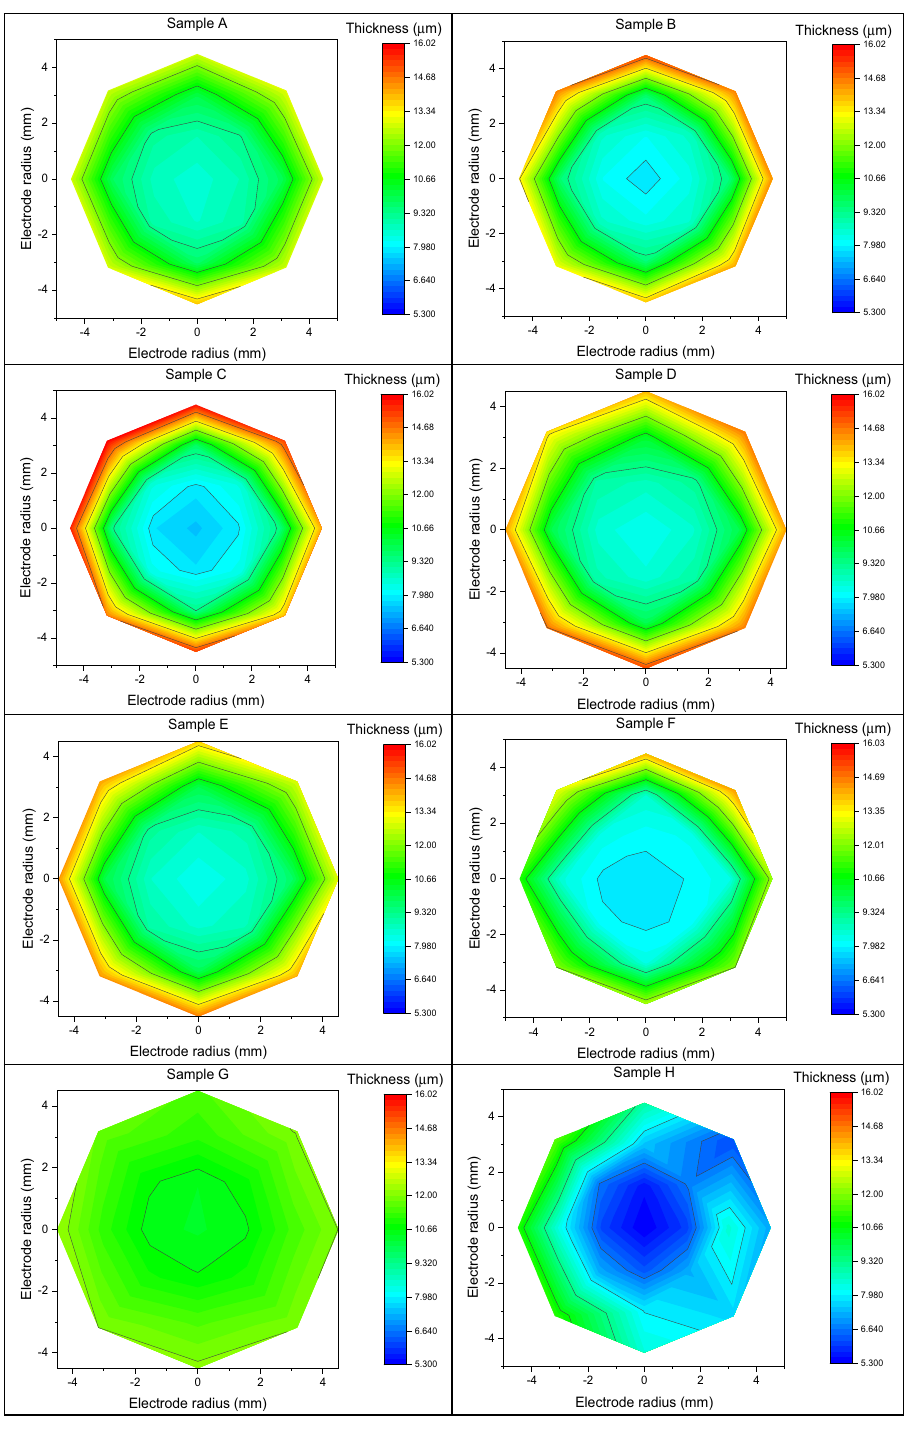
Figure 5. Graphic representation of the thicknesses by colour scale of each